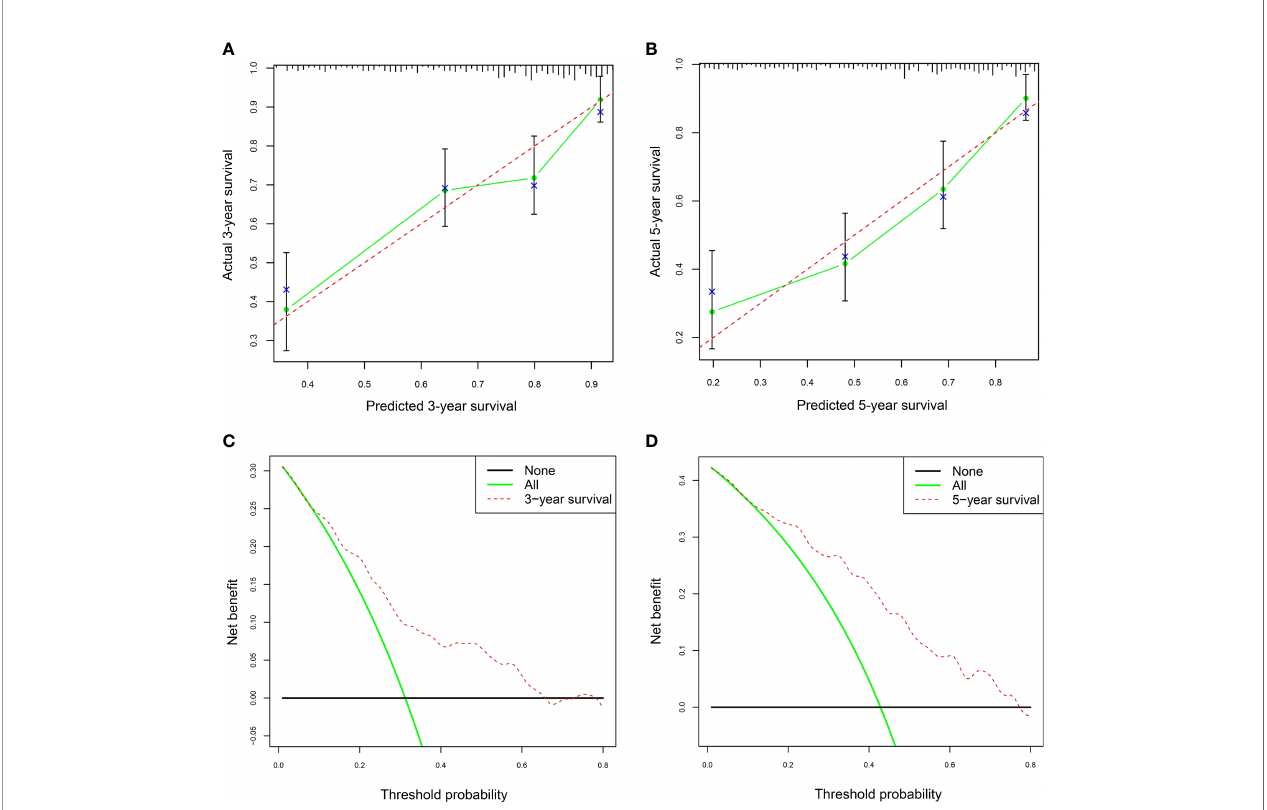
FIGURE 5 | The calibration curves and decision curve analysis (DAC) of the nomogram in AAV. (A) The nomogram calibration curve for the 3-year survival rate in AAV patients. (B) The nomogram calibration curve for the 5-year survival rate in AAV patients. (C) Nomogram decision curve analysis (DCA) for the 3-year survival rate in AAV patients. (D) Nomogram DCA for the 5-year survival rate in AAV patients. AAV, antineutrophil cytoplasmic antibody (ANCA)-associated vasculitis. In panels (A, B) , the dashed lines serve as the reference lines. In panels (C, D) , the horizontal black line and green oblique line refer to no AAV patient and all AAV patients,